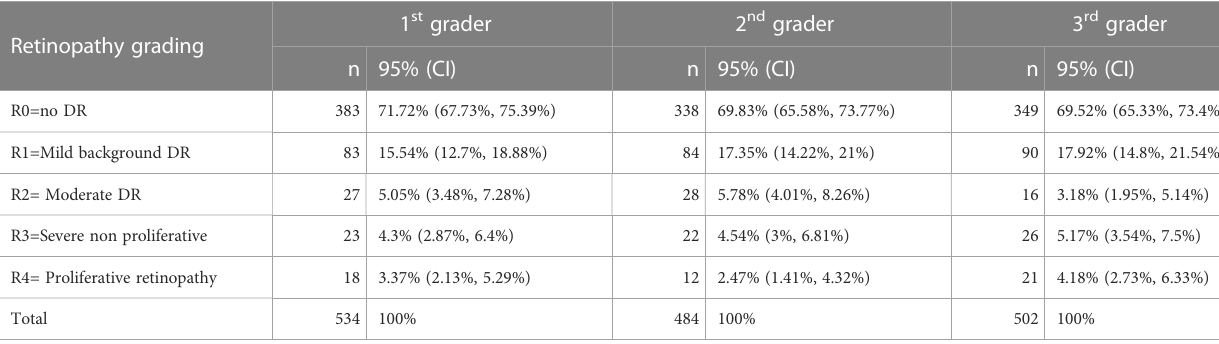
TABLE 1 Retinopathy grading of 1 st , 2 nd and 3 rd